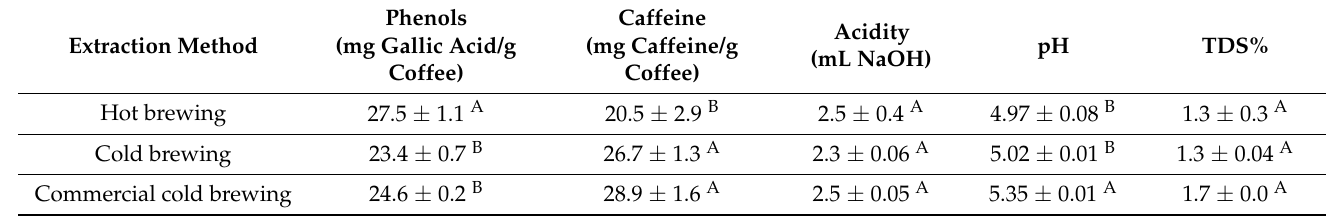
Table 6. Comparison of the extraction method of coffee and their physicochemical properties (avg ± SD, n = 3)